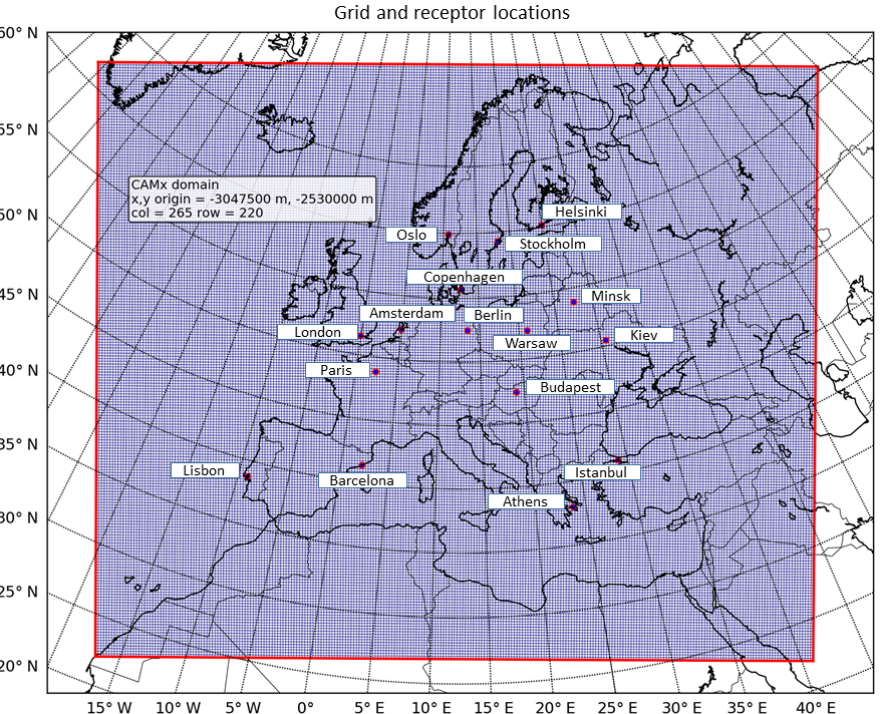
Figure 1. CAMx modeling domain with 270 by 225 grid cells at 23km horizontal grid resolution. The figure also shows the 16 cities considered for the source attribution